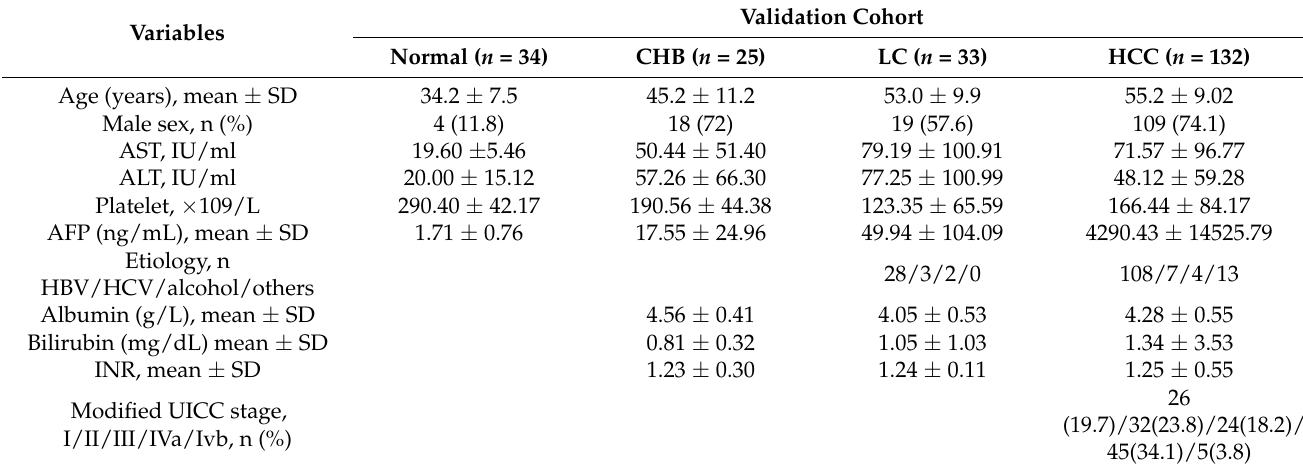
Table 1. Baseline characteristics of patients in validation cohort ( n = 224).